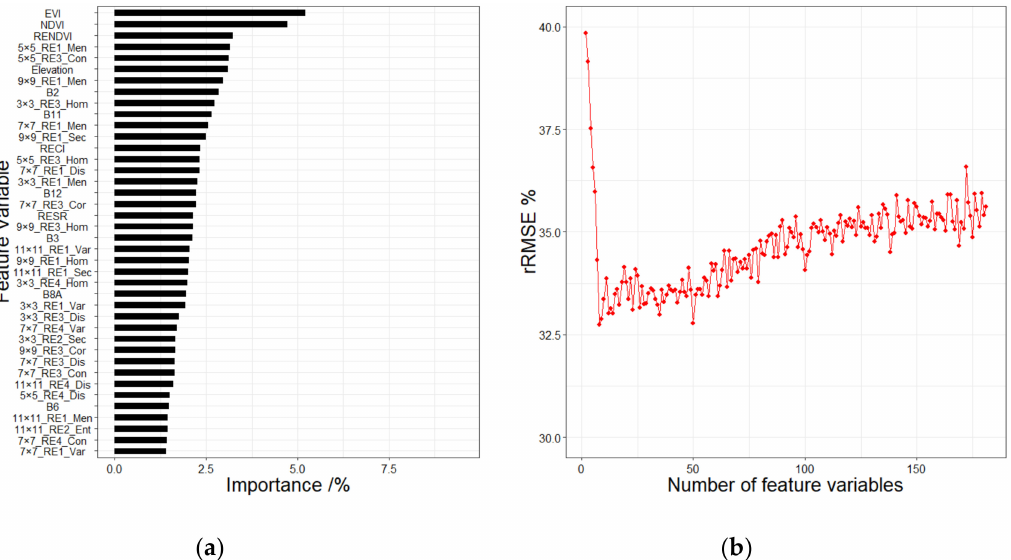
Figure 8. ( a ) The partial importance ranking of spectral variables, topographic factors, and texture features, ( b ) the change trend of rRMSE under di ff erent numbers of the feature